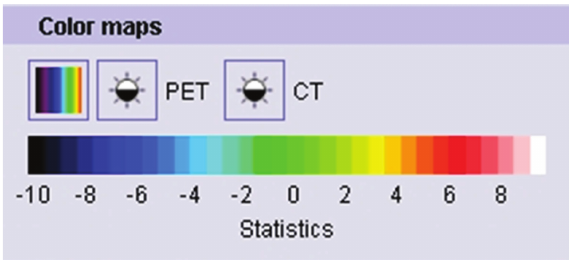
F 2: French Color coding for statistical reconstruction of the PET-CT scan